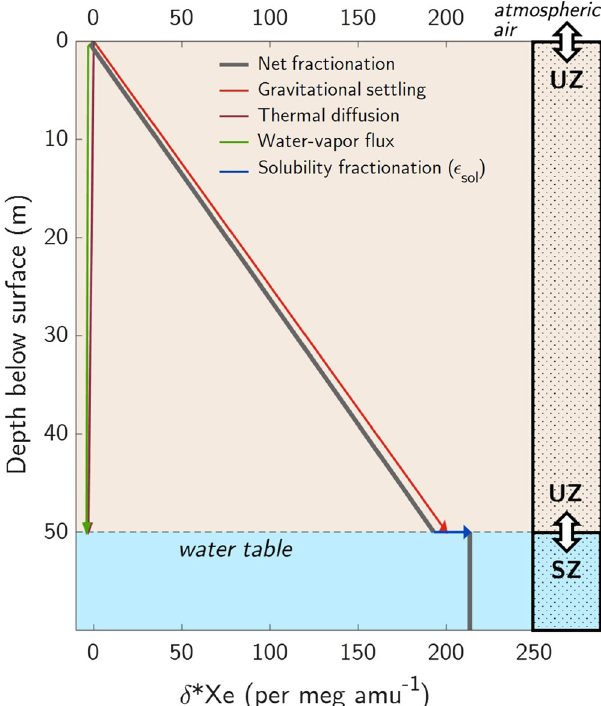
Fig. 1 Steady-state xenon isotopic fractionation in an uncon fi ned aquifer. Gravitational settling causes mass difference-normalized, heavy-to-light xenon isotope ratios ( δ *Xe) in unsaturated zone (UZ) air to increase with depth below the land surface, relative to atmospheric air. At the water table, dissolved gases in the saturated zone (SZ) equilibrate with deep UZ air. Solubility fractionation causes δ *Xe to further increase in the dissolved phase relative to the gas phase. Note that nearly all water-vapor fl ux fractionation occurs between the surface and shallow wetting front (at one meter depth in this idealized illustration), below which water-vapor fl ux fractionation is nearly constant with depth and only changes due to its weak sensitivity to temperature 12,13